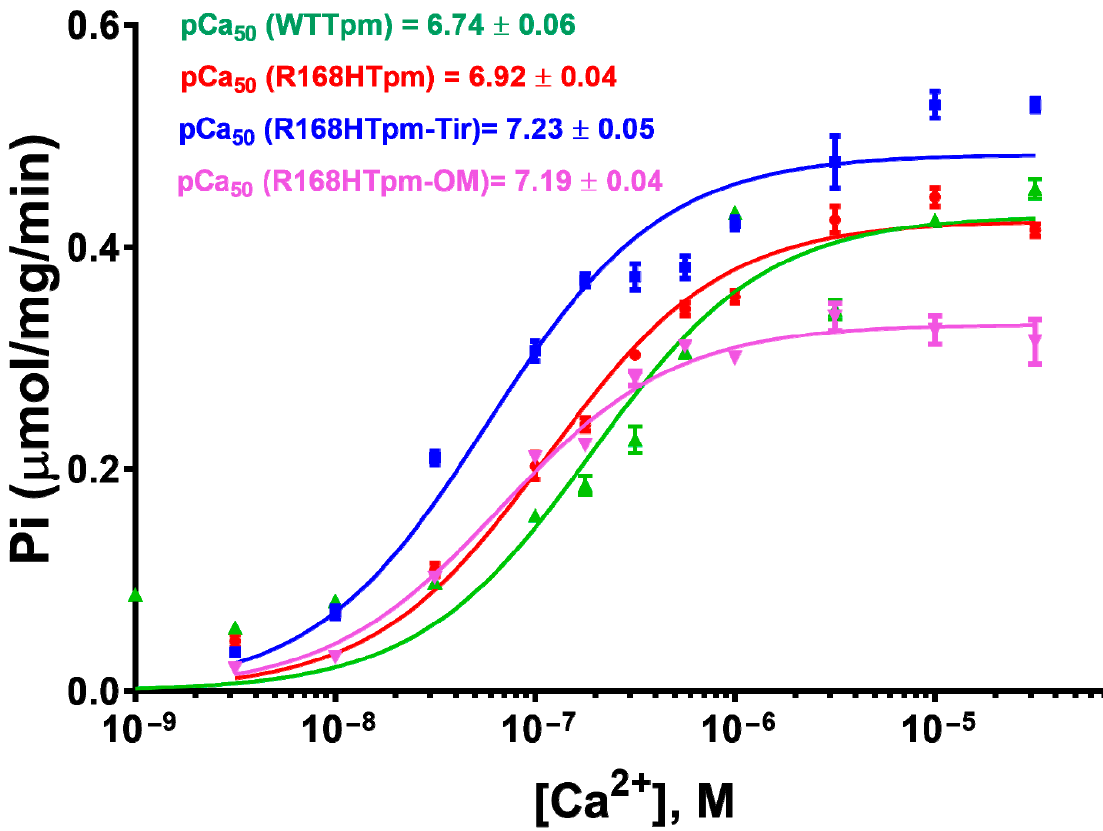
Figure 4. Effect of the R168H mutation in γ -tropomyosin (Tpm) on the sensitivity of thin filaments to Ca 2+ activation. Ca 2+ dependence was determined for fully regulated reconstituted thin filaments. Actin–S1 ATPase was measured in the presence of wild-type (WT) Tpm (denoted by triangular symbols) and R168H-mutant Tpm (round symbols) at 25 °C. The effects of two chemical compounds were shown—tirasemtiv (Tir, squire symbols) and omecamtiv mecarbil (OM, inverted triangles). Error bars indicate ± SEM. The pCa values were calculated from the data averaged from three experiments. Conditions are given in Materials and Methods. ATPase assay revealed that the mutation increases the Ca 2+ sensitivity of thin filaments. The midpoints of the curves (pCa 50 ) are 6.74 ± 0.06 for filaments containing WTTpm and 6.92 ± 0.04 for those reconstituted with R168HTpm. Tir (5 µ M) and OM (20 µ M) increased the value of pCa 50 to 7.23 ± 0.05 and 7.19 ± 0.04, respectively ( p <